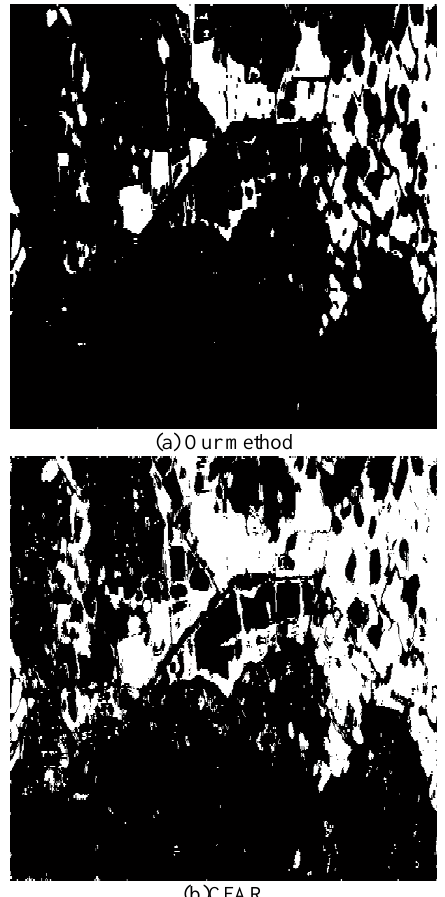
Figure 6. Change detection results of Our method on SAR image dataset with different regions